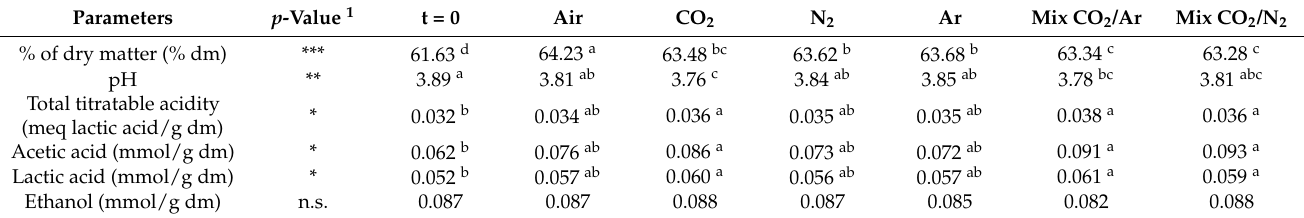
Table 2. Chemical composition of the sourdough bread produced at time zero and after 8 days of storage under different MAPs. Results are expressed as mean ± SD (n =